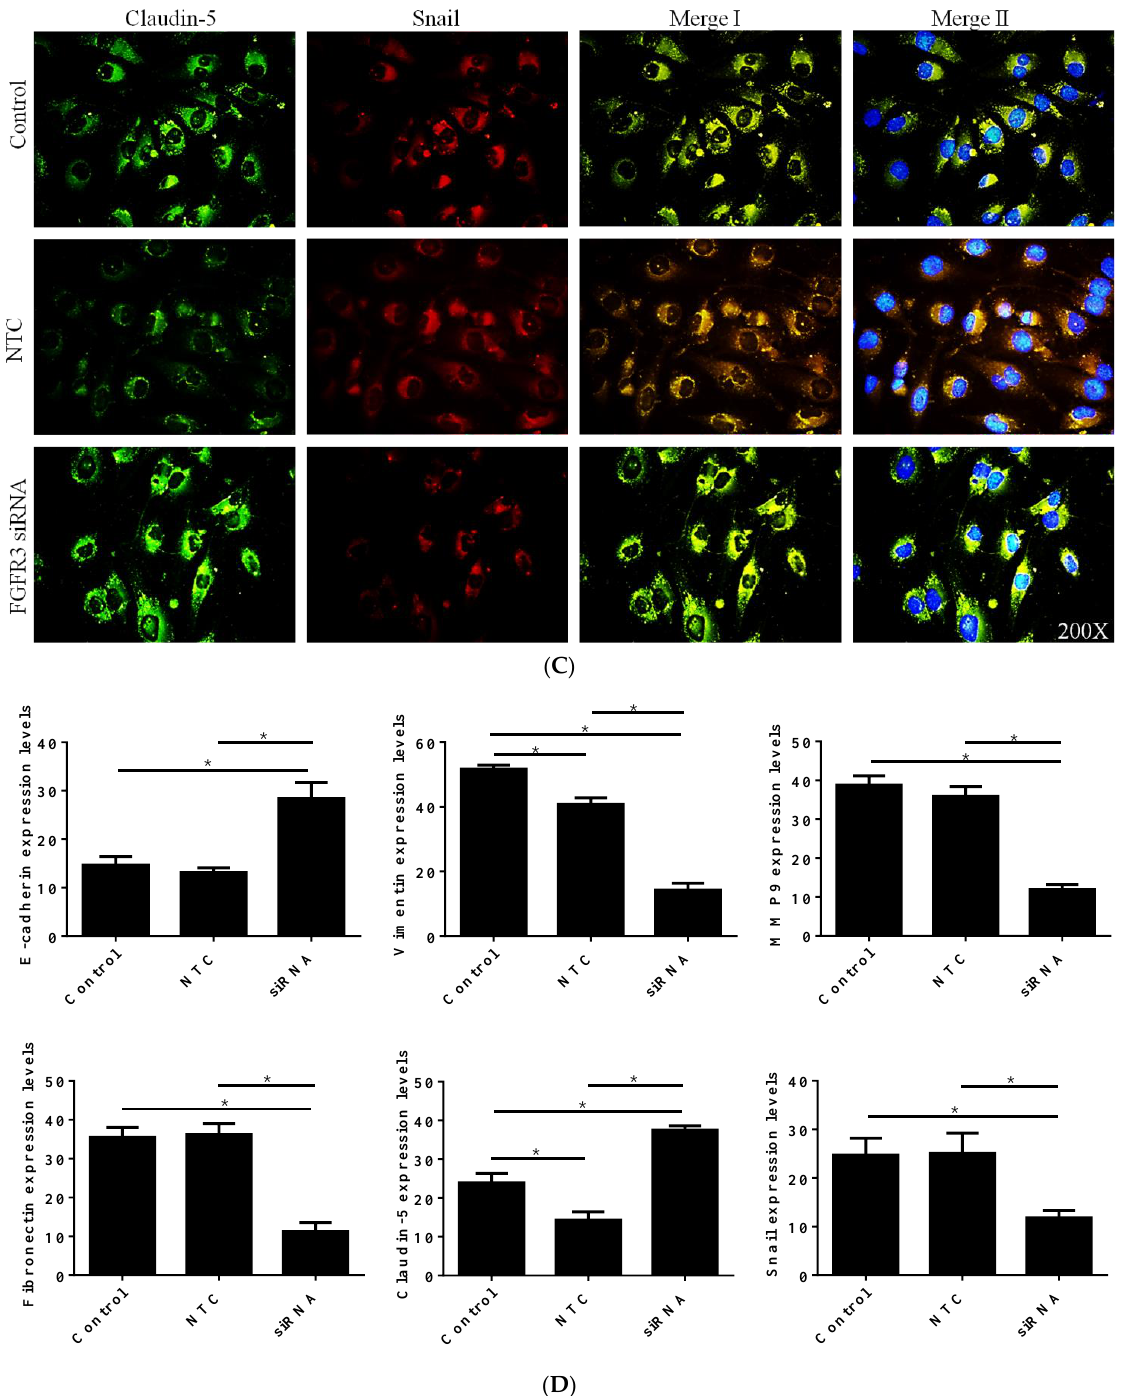
Figure 5. FGFR3 gene silencing inhibited expression of epithelial–mesenchymal transition markers and transcription factor in cultured UTUC cells. The BFTC-909 cells transfected with FGFR3-targeted siRNA or scramble non-target control (NTC) for 48 h were subjected to immunofluorescent staining for cellular expression of ( A ) E-cadherin (red) and vimentin (green); ( B ) alternatively, for that of MMP9 (red) and fibronectin (green); ( C ) or that of Snail (red) and Claudin-5 (green). Cell nuclei were visualized via DAPI (blue). Merge I images contain signals of red and green channels, while merge II images contain those of triple colors. ( D ) The fluorescence intensities of each channel were quantified by counting 5–10 different fields per sample. Data are expressed as means ± SEM ( n = 3). * indicates that p < 0.05 between the indicated groups. Original magnification: 200 ×